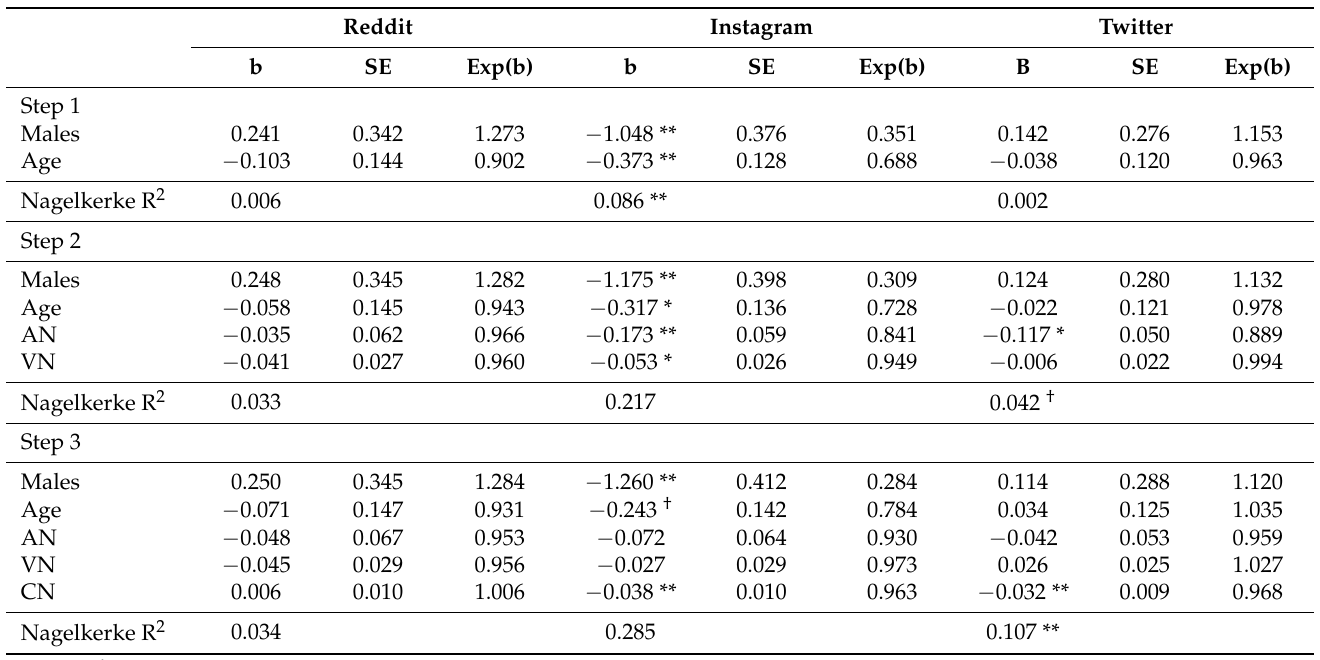
Table 2. Logistic regression predicting social media usage for Reddit, Instagram and Twitter, showing unstandardized coefficients (b), standard errors (SE) and the odds ratios for the unstandardized coefficients (Exp(b)).